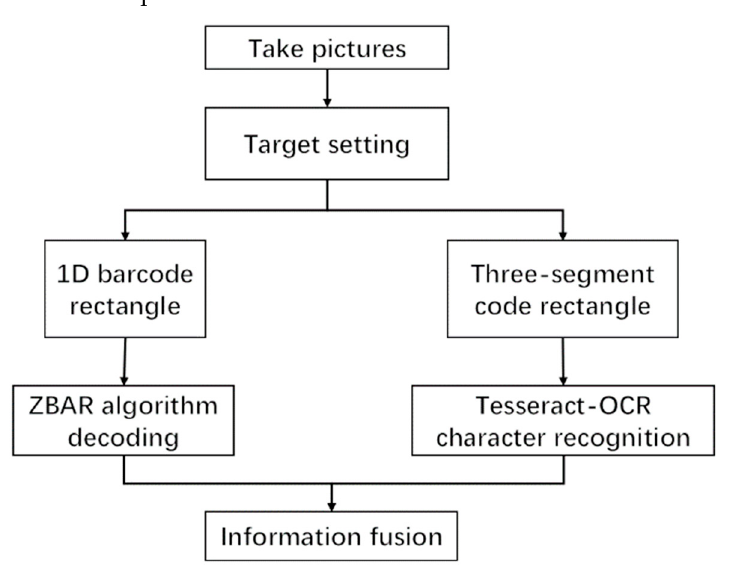
Figure 1. Method structure diagram.